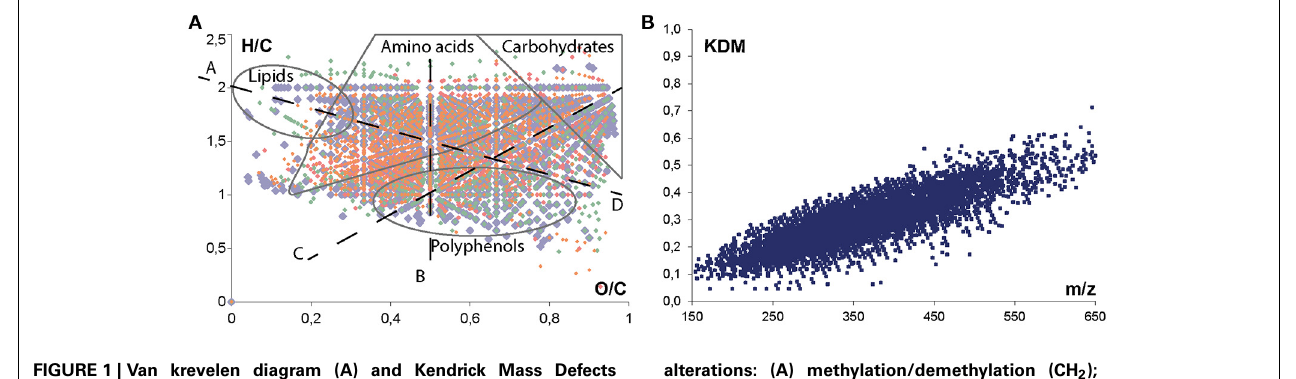
alterations: (A) methylation/demethylation (CH 2 ); (B) hydrogenation/dehydrogenation (H 2 ); (C) hydratation/condensation (H 2 O) and (D) oxidation/reduction (O). Colors correspond to elemental formulas composition: (CHO) blue; (CHOS) green; (CHON) red; and (CHONS)